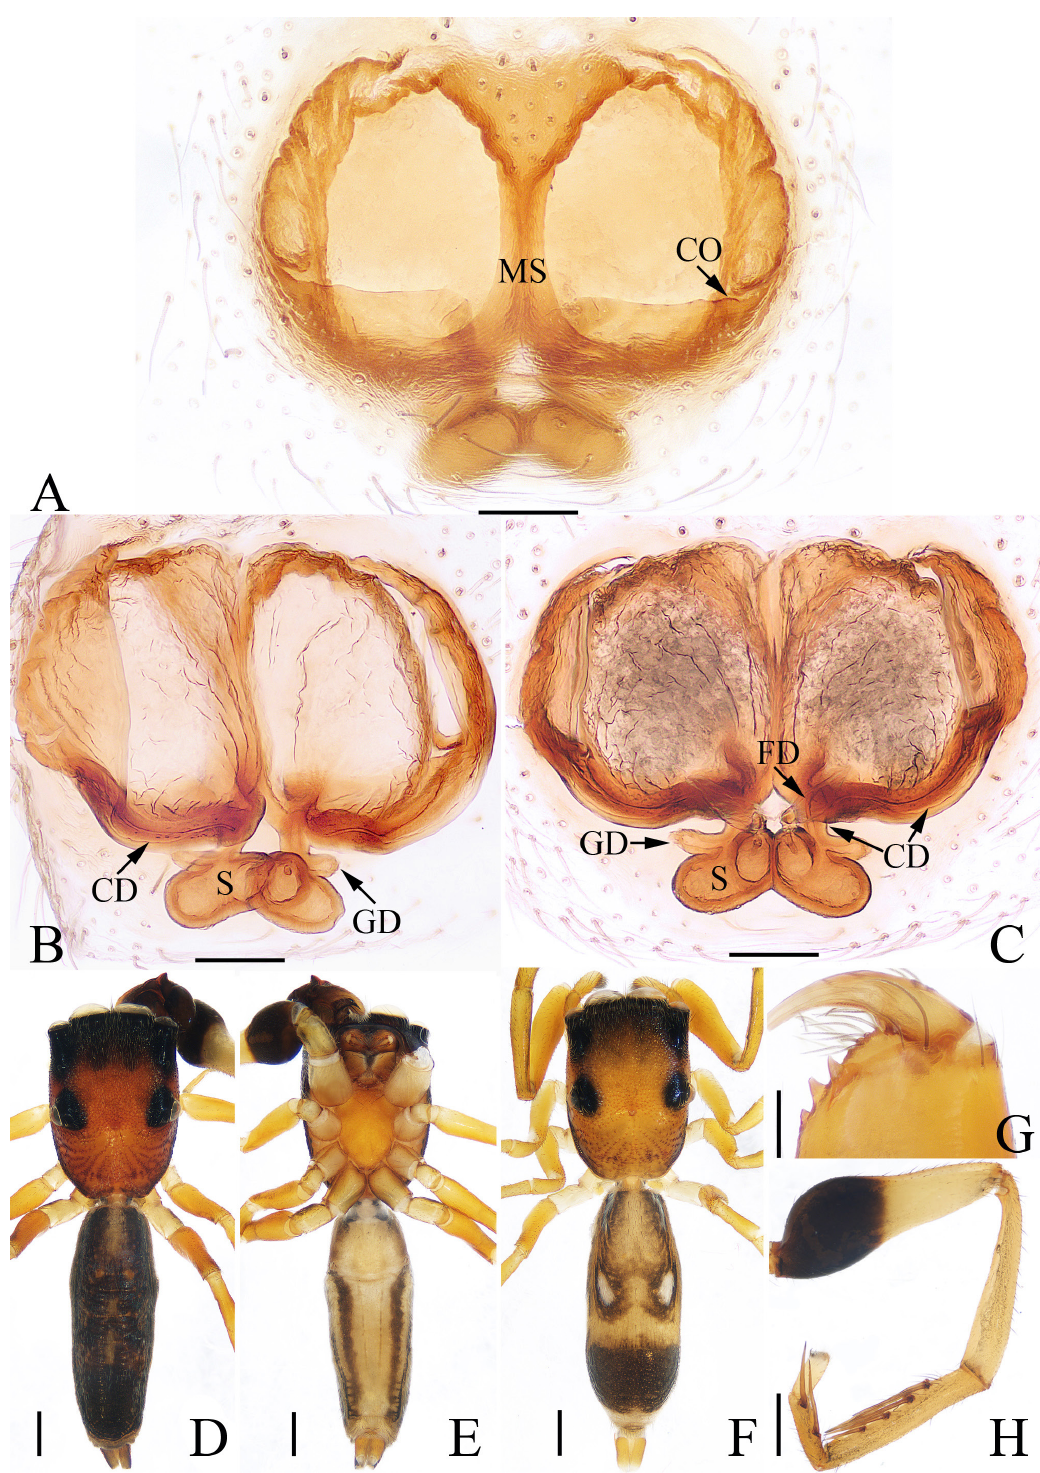
Fig. 2. Synagelides bohdanowiczi sp. nov. A–C, F . Paratype, ♀ (TRU-Salticid-0011). D–E, G–H . Holotype, ♂ (TRU-Salticid-0010). A . Epigyne, ventral view. B . Epigyne, dorsolateral view. C . Epigyne, dorsal view. D . Habitus, dorsal view. E . Habitus, ventral view. F . Habitus, dorsal view. G . Chelicerae, dorsal view. H . Leg I, prolateral view. Abbreviations: see Material and methods. Scale bars: A–C, G = 0.1 mm; D–F, H = 0.5